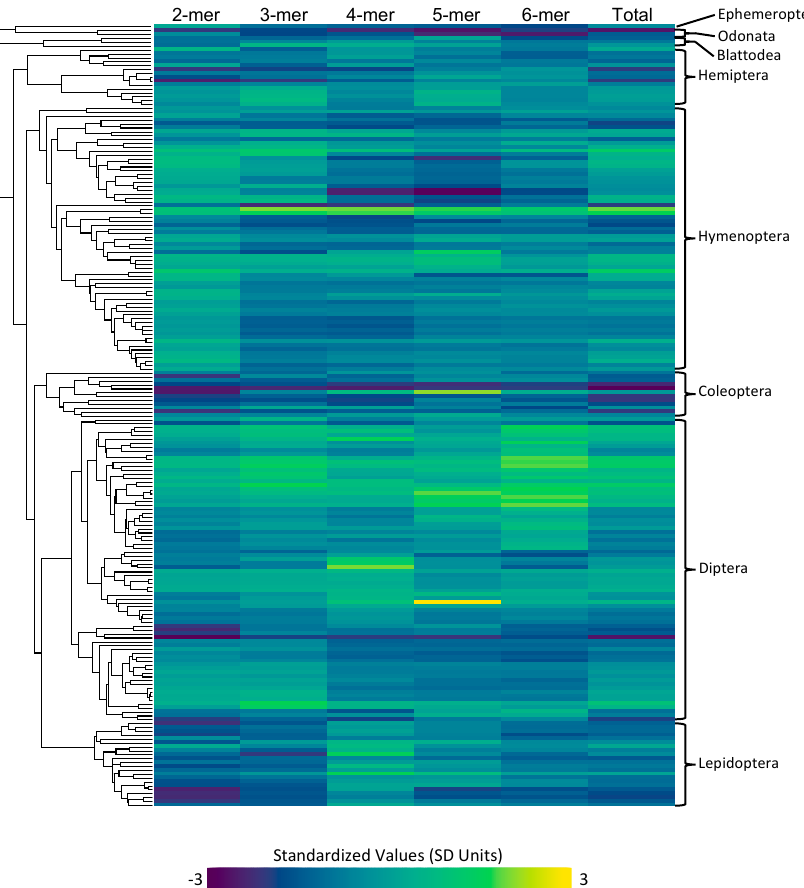
Figure 1. The inferred microsatellite counts for each type (2mer, 3mer, 4mer, 5mer, 6mer, and total), with cool colors representing lower microsatellite content and warm colors representing higher microsatellite content. The values are standardized across all types. The phylogeny depicting the row that corresponds to each species can be seen on the left, and the orders that each of these species encompass is on the right.